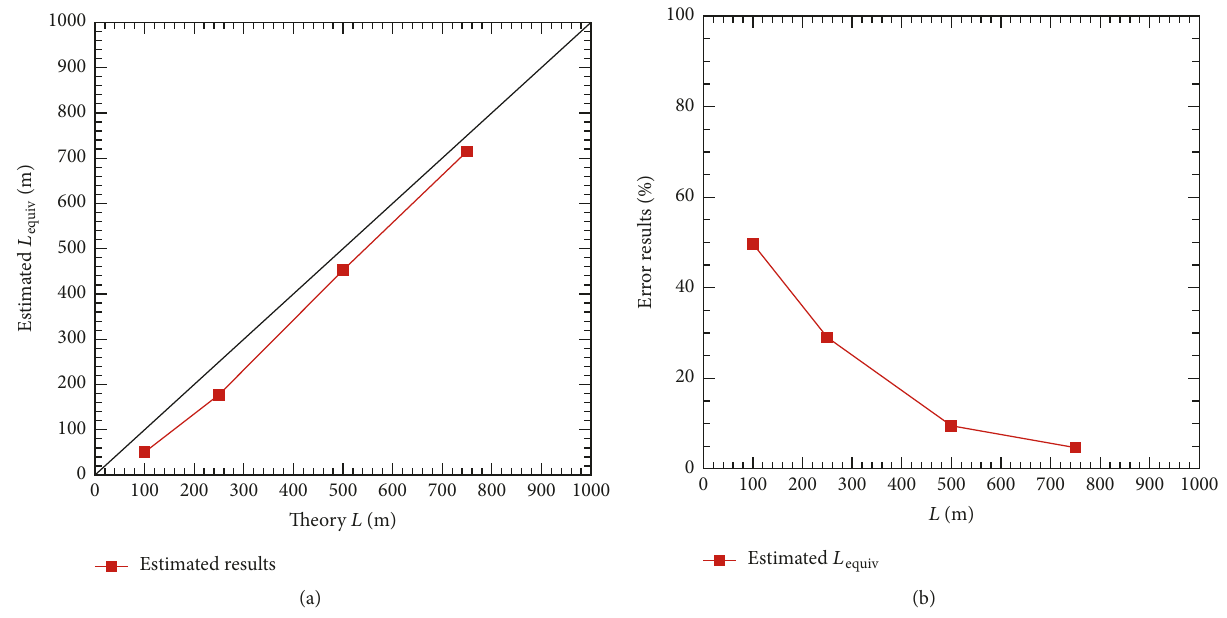
Figure 6: Results of the 2D aquifer of the (a) scatter plot of the theory 𝐿 versus the estimated 𝐿